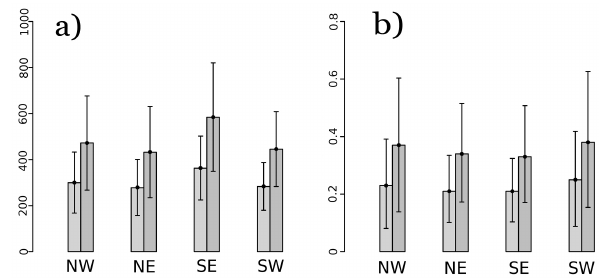
Fig. 5. Mean (a) N ccn (cm − 3 ) and (b) activated fraction for differ- ent surface wind directions observed at the MVNP site. Light grey indicates data for SS = 0.3% and dark grey for SS = 0.5%. The error bars show one standard deviation above and below the